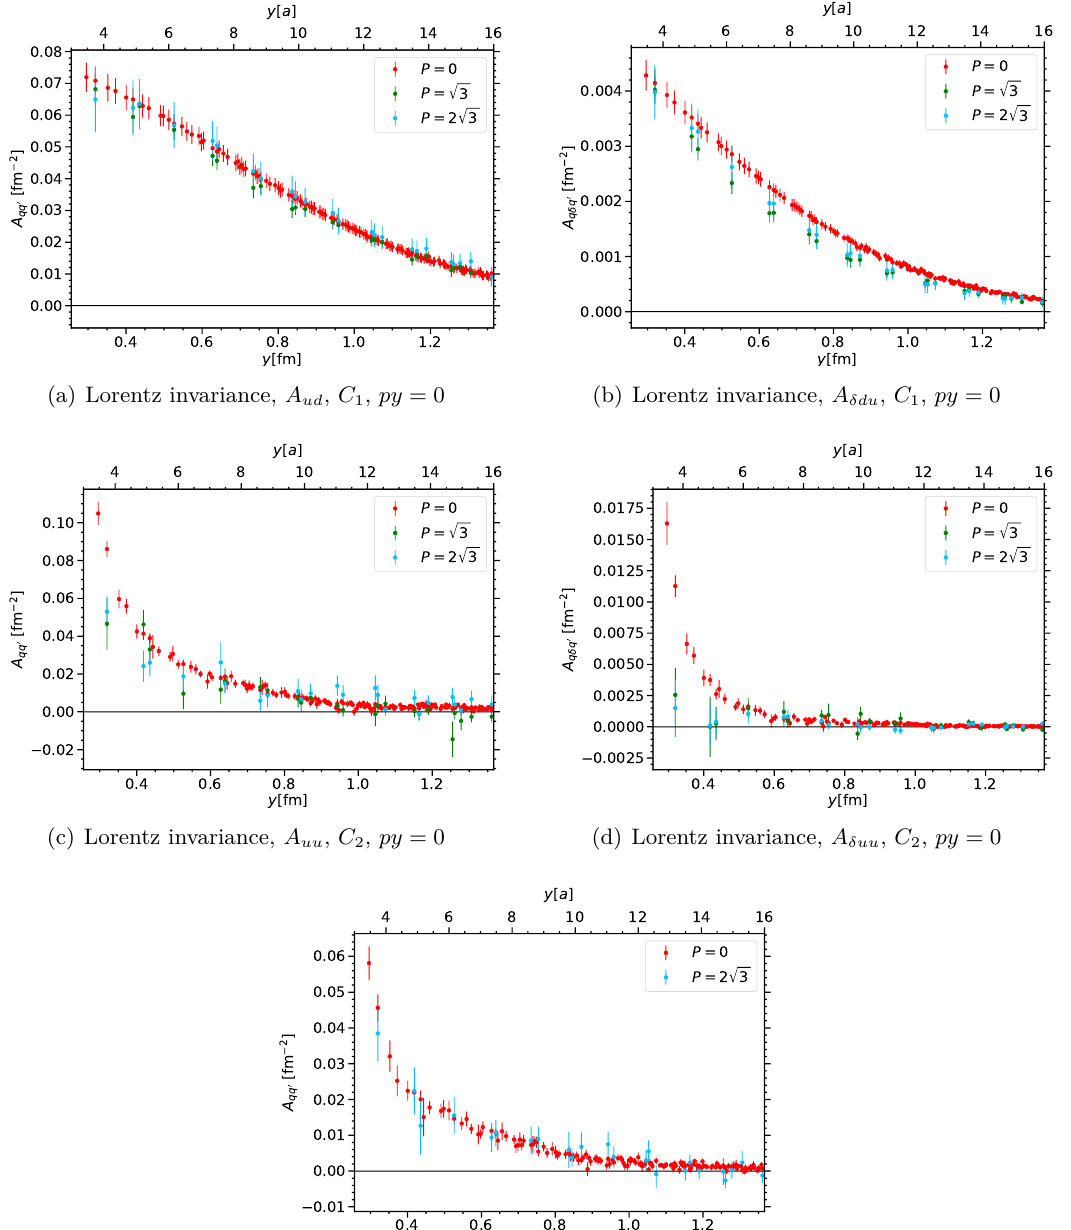
√ √ 3 (green) and P = 2 3 (blue). (a) and A (b), the C contributions to A (c), ud δdu 2 uu √ 3 for clarity, since they